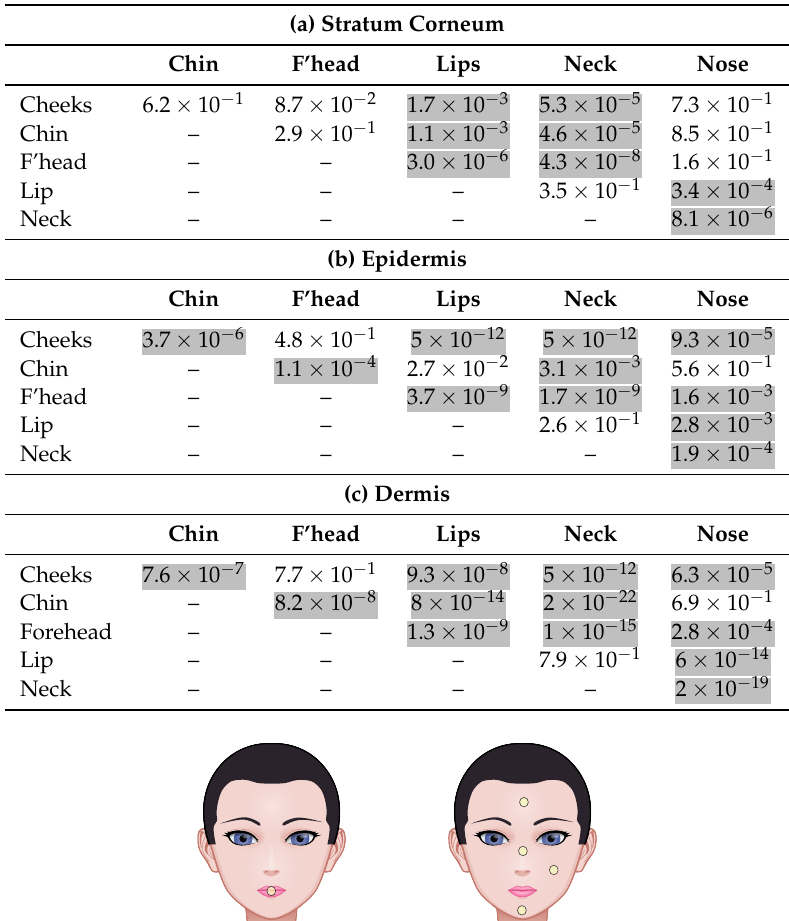
Thickness of the stratum corneum, epidermis and dermis: results of the pairwise comparisons ( p -value) between the six facial areas. Highlighted figures indicate significant differences ( α ∗ = 3.3 × 10 − 3 ).